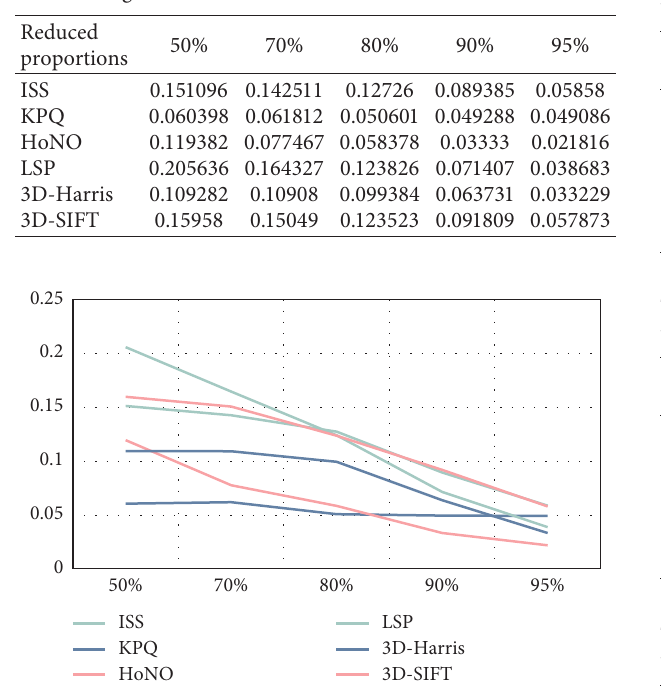
of the key point de- outlier